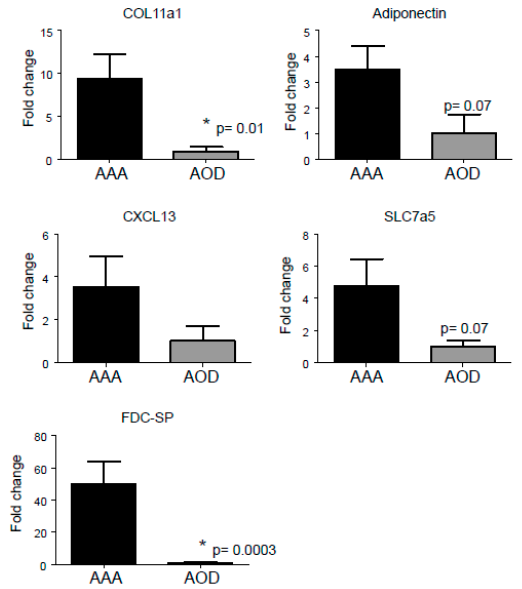
Figure 3. qPCR analysis of significantly regulated genes from the top 10 selection (Table 4), verified by qPCR. Plotted are the fold changes of COL11A1, ADIPOQ, CXCL13, SLC7a5, and FDCSP gene (AAA versus AOD n = 5). * p < 0.05 versus AAA.